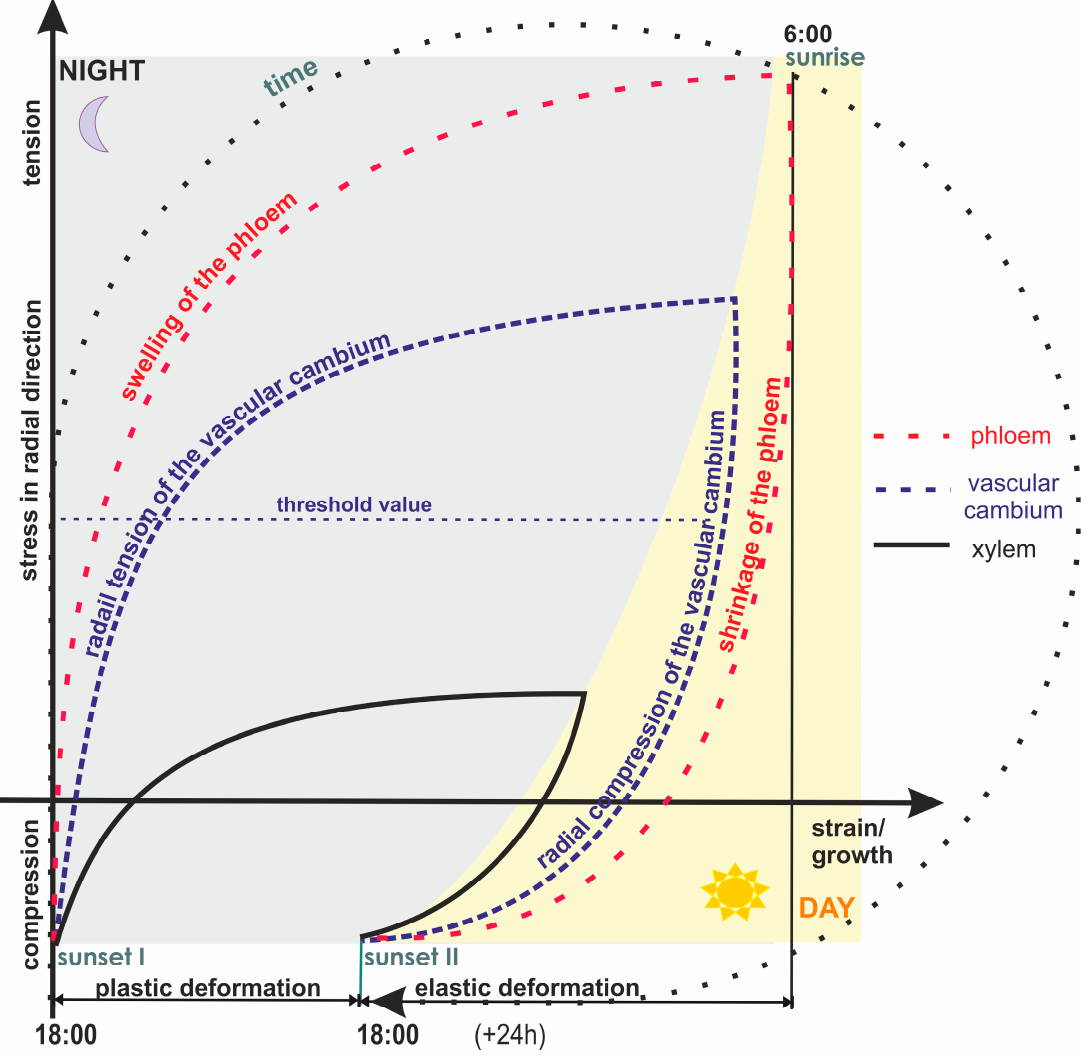
Figure 7. Hysteresis loop with plastic and elastic components illustrating the diurnal deformation of xylem and phloem. The elastic strain is due to the tensile stress of the vascular cambium below the threshold value while the plastic strain is due to the stress above the threshold value.